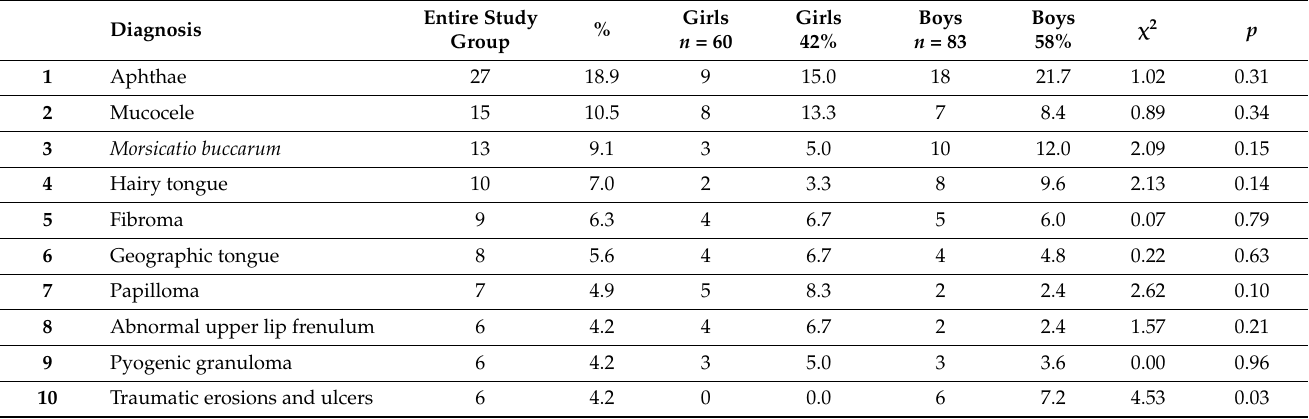
Table 3. The 10 most frequent oral mucosa lesions (OMLs) in pediatric patients in relation with gender.